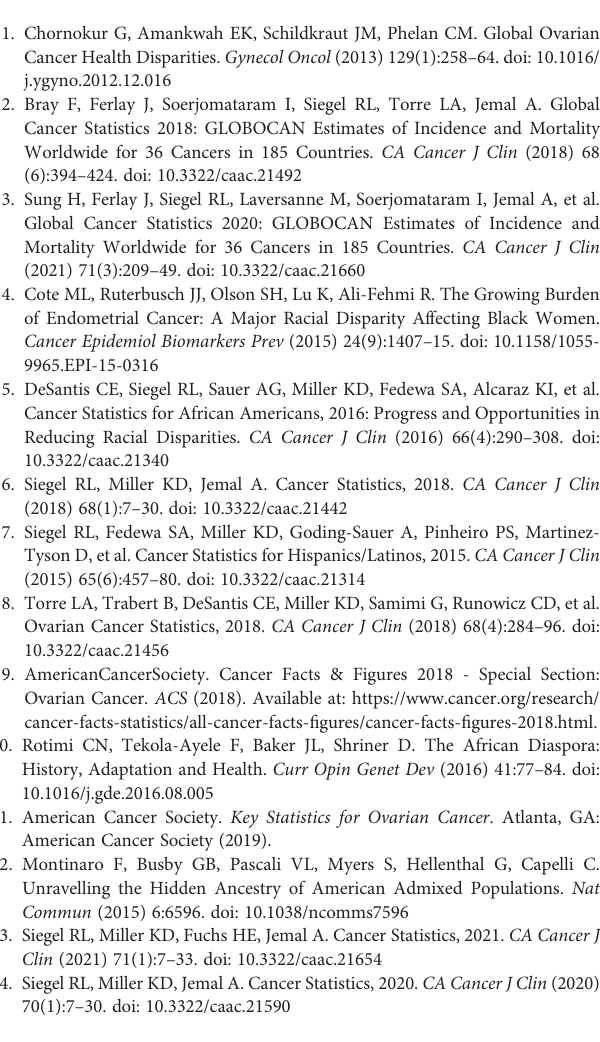
Supplementary Figure 1 | Distribution of cases by age across comparative groups using SEER data. Black, White, and Nigerian cohorts. (A) . Nigerian women diagnosed with EOC skew left of both Black and White women using SEER categorical age distribution. (B) . No observed differences in age at diagnosis between Nigerian women Germ Cell versus women in the US. (C) . No observed differences in age at diagnosis between Nigerian women Sex Cord Stromal tumors versus women in the